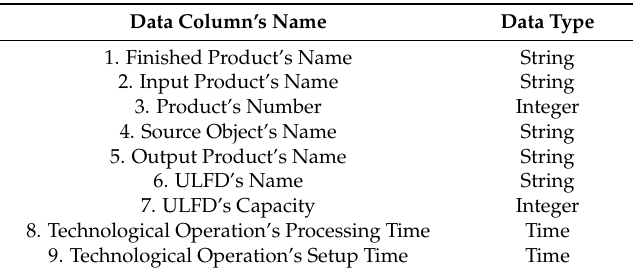
Table 6. Structure of the technological operation data